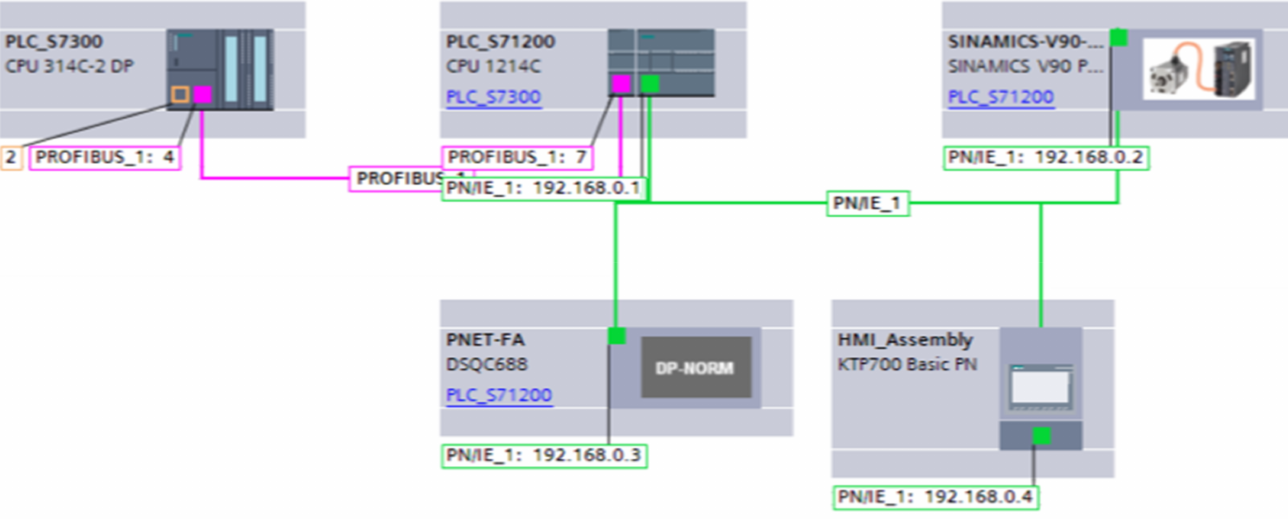
Figure 2. Flexible Cell Siemens S7-1200 PLC hardware